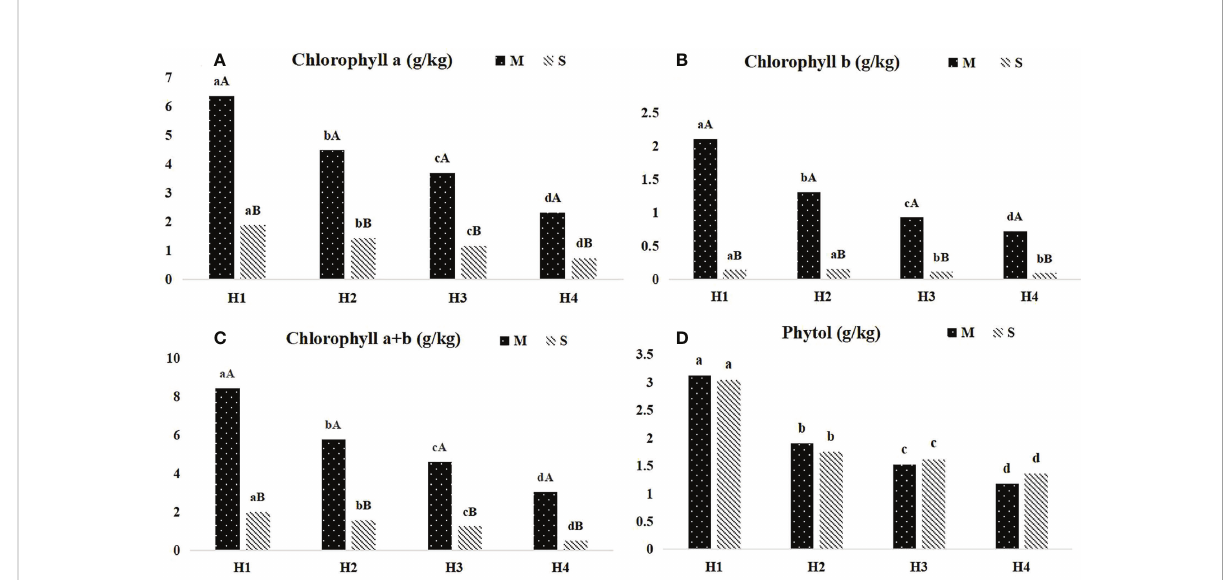
FIGURE 1 Dynamics of chlorophyll and phytol content in different height Pennisetum sinese and silage. The contents of chlorophyll a, chlorophyll b, chlorophyll a+b and phytol (A – D) . M: Pennisetum sinese material; S: Pennisetum sinese silage. Boxes with a different letters above the error bars are signi fi cantly different between different height (a – d) or material and silage (A, B) at P < 0.05.